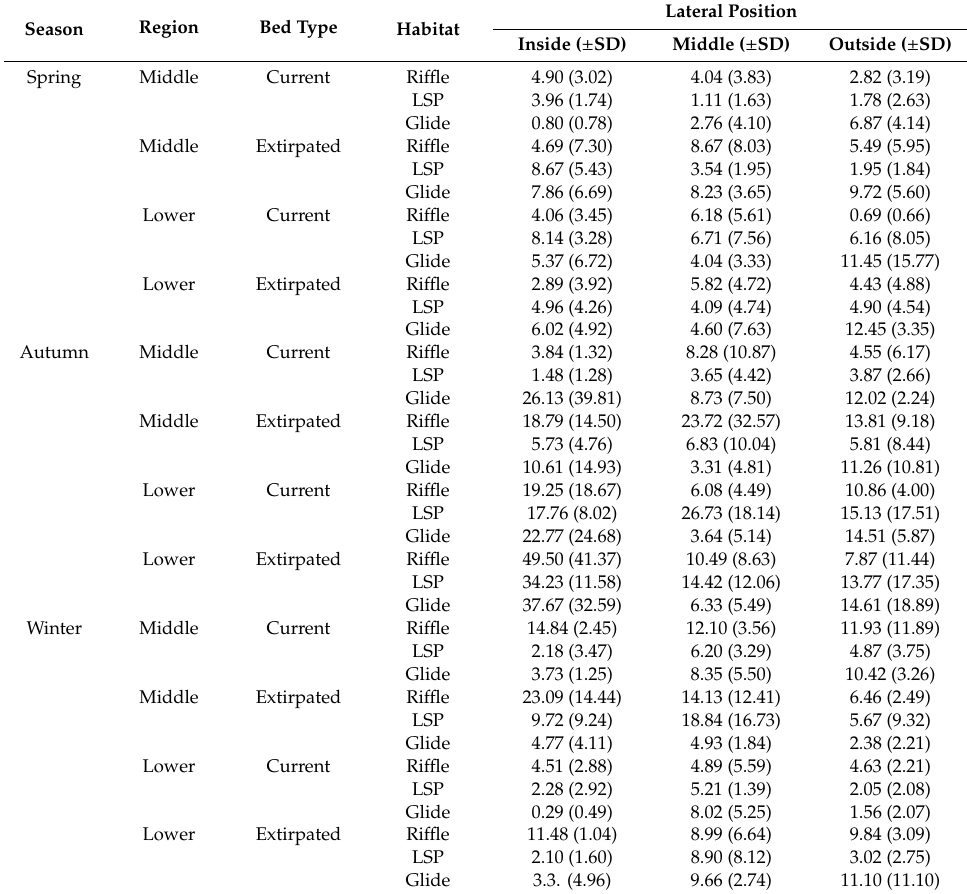
Table A5. Pooled mean stream power (W / m) ( ± SD) by lateral position (Inside, Middle, Outside) across seasons (Spring, Autumn, Winter), regions (Middle, Lower), bed type (Current, Extirpated), and habitat (Ri ffl e, LSP, Glide).